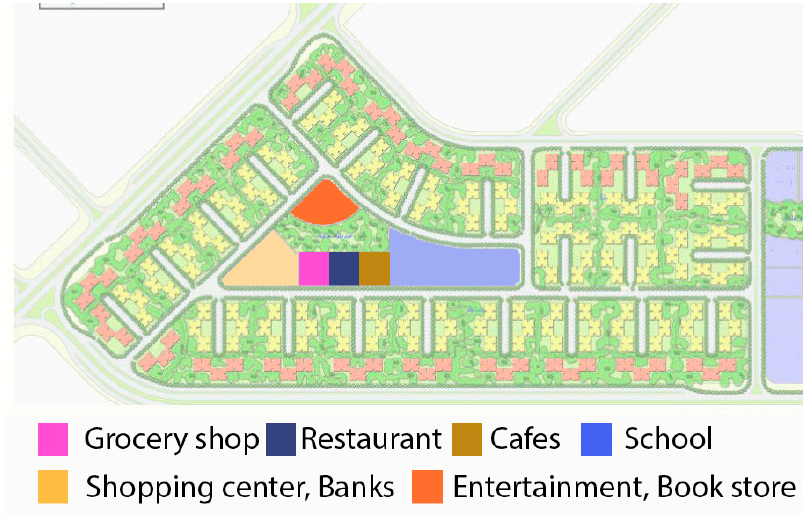
Figure 4. The location of the amenities in the selected neighborhood. Source: Adapted by the researchers retrieved from [43].